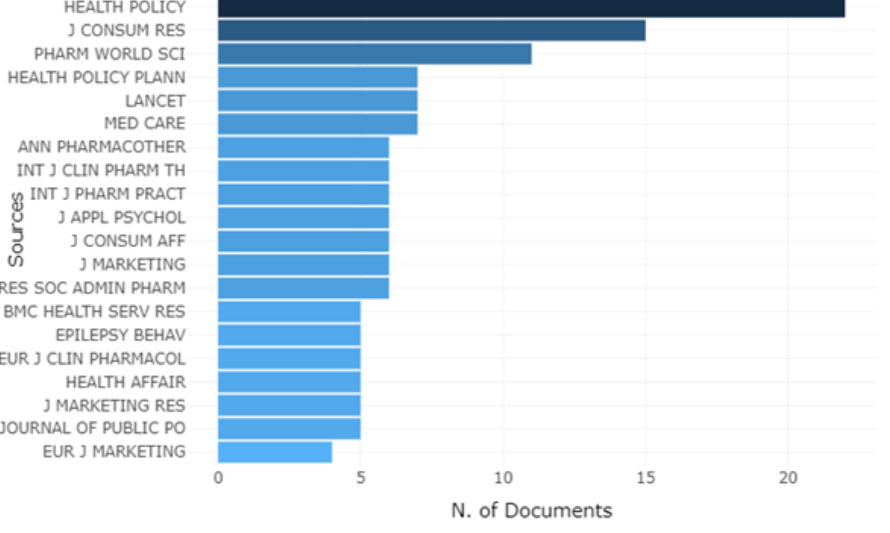
Figure 3. Spectroscopy analysis of the year of publication of the references. Figure 4 shows the co-citation network of the references considering a minimum of three citations. We found that references from the research corpus can be grouped into